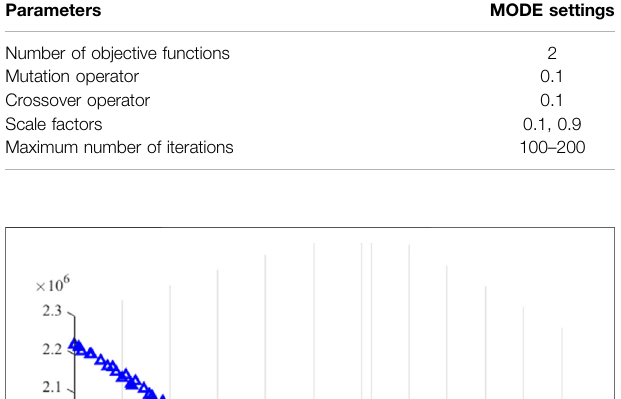
TABLE 4 | Parameters of MODE setting Parameters